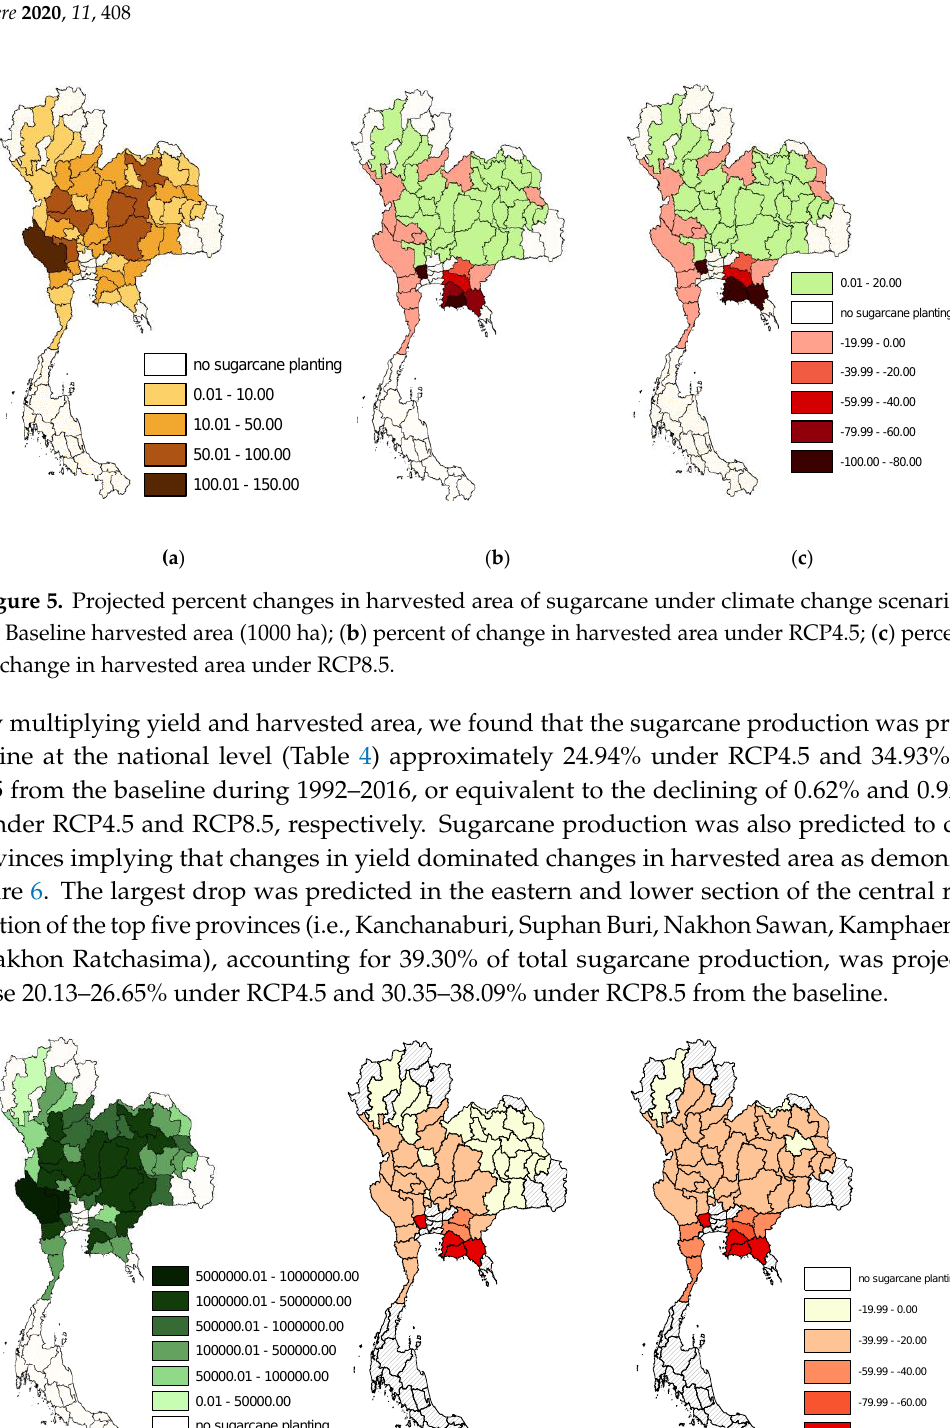
Figure 4. Projected percent changes in yield of sugarcane under climate change scenarios. ( a ) Baseline yield (kg/ha); ( b ) percent of change in yield under RCP4.5; ( c ) percent of change in yield under RCP8.5.